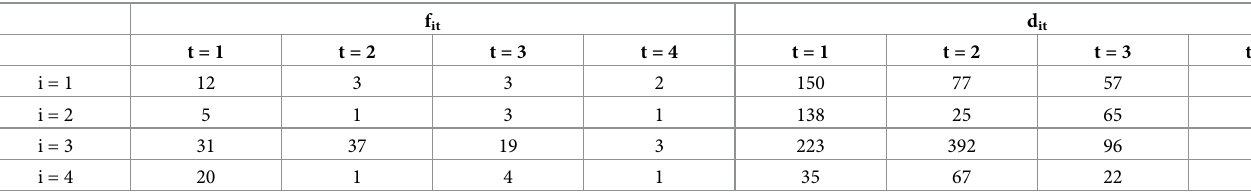
Table 4. The total demands and their available displays at each period.